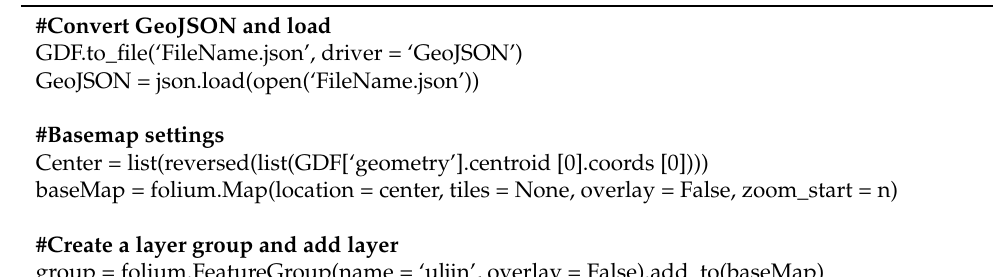
Table 3. Pseudocode of the web map